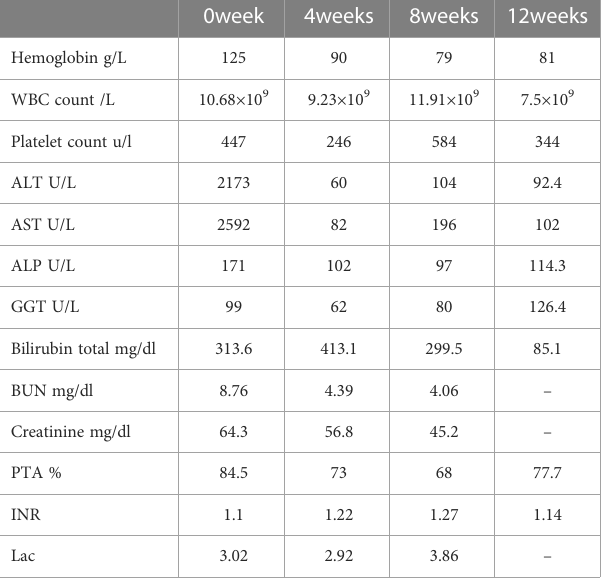
TABLE 1 Laboratory fi ndings of the patient throughout different